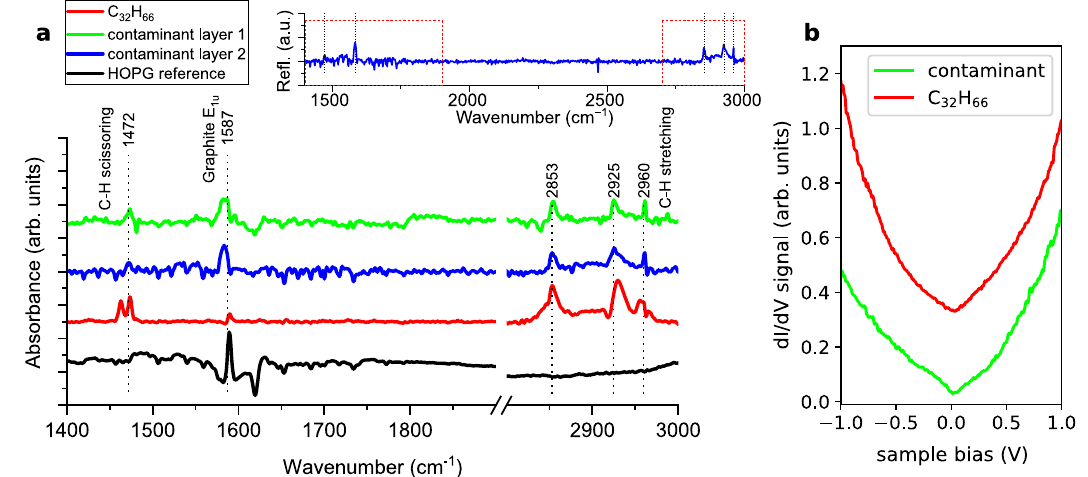
Fig. 2 | Spectroscopy of the molecular contaminant layer. a Grazing angle infraredspectraondifferentlycoveredgraphitesubstrates,revealingthemolecular vibrational modes of the adsorbates. The clean HOPG used as reference (black) shows only the E 1u graphite band at 1583cm − 1 , while the HOPG samples covered with adsorbates (blue, green) or vapor-deposited C 32 H 66 layer show the C – H stretching and scissoring modes of alkanes. Inset: The spectrum of “ contaminant layer2 ” inthefullwavenumberrange.Therearenootherpeaksasidefromtheones